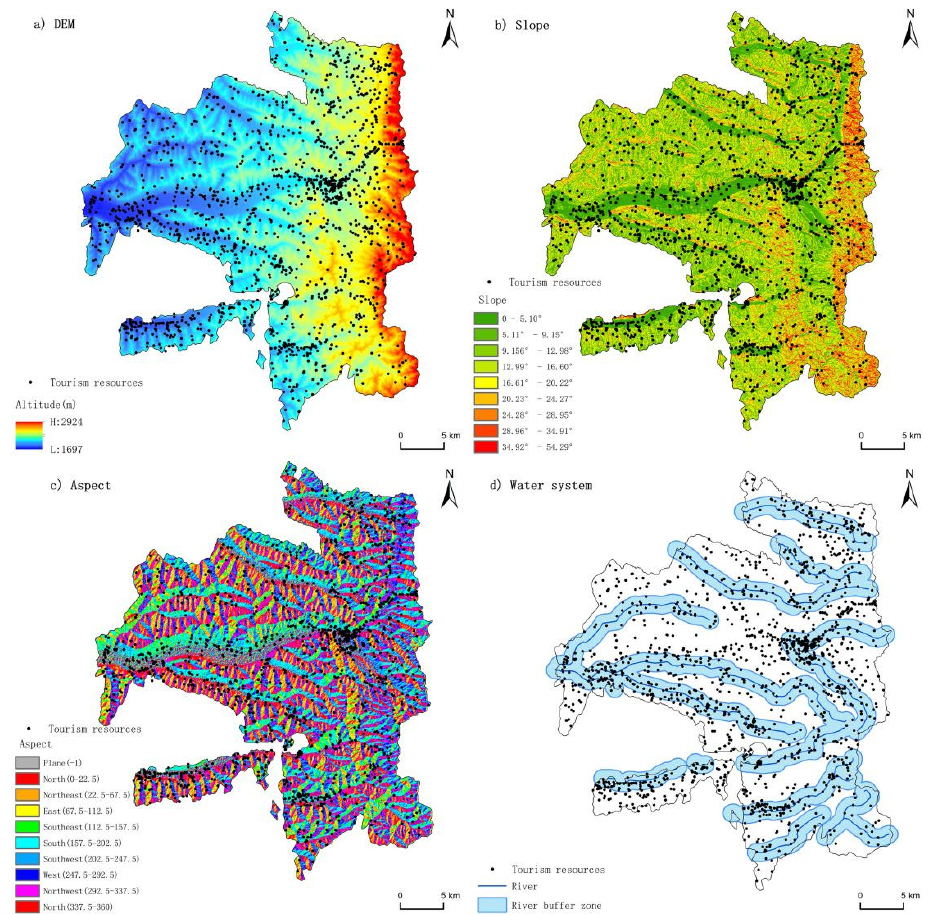
Figure 7. The relationship between the distribution of tourism resources and the natural geographical environment in Longde County. Data source: National Basic Geographic Information System database and the National Basic Geographic Information System database.